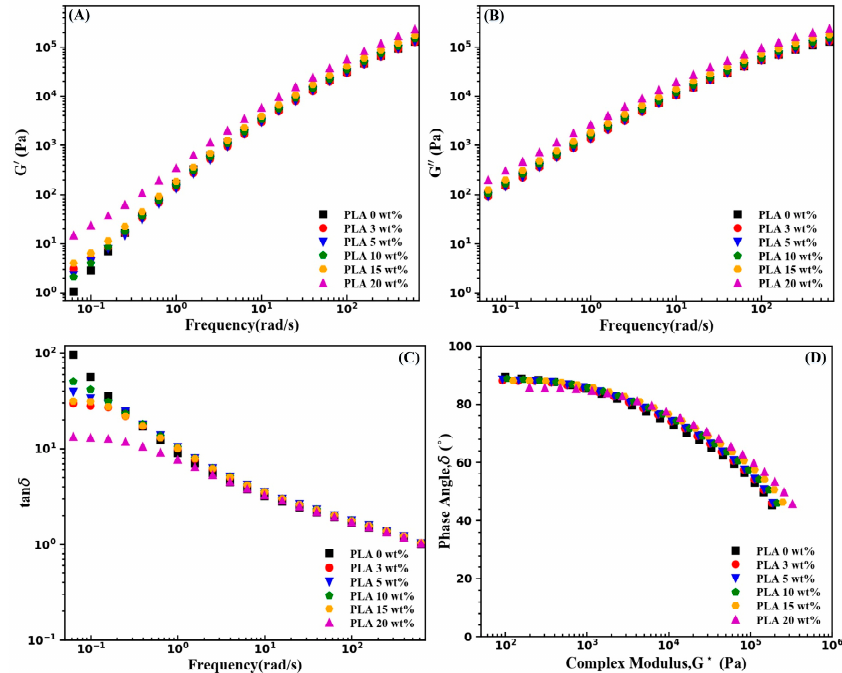
Figure 4. Rheological behavior of the as-extruded PBS/PLA composites at 130 °C; ( A ) Frequency dependence of G’( ω ); ( B ) Frequency dependence of G”( ω ); ( C ) Frequency dependence of tan δ ; ( D ) Van Gurp plots.